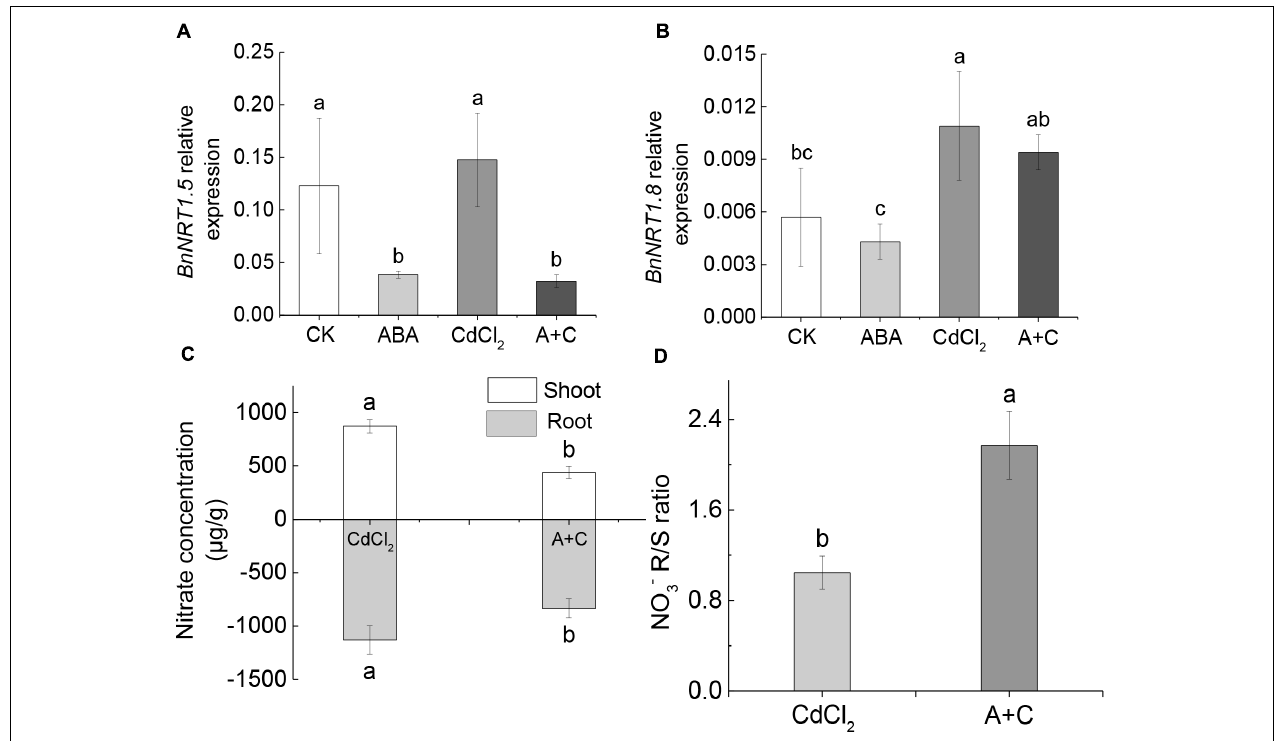
FIGURE 6 | Exogenous ABA affects the distribution of NO − 3 under Cd conditions. (A) Gene expression of BnNRT1.5 in different treatments (CK, ABA, CdCl 2 , A+C). (B) Gene expression of BnNRT1.8 . (C) The concentration of NO − 3 in the shoot and root. (D) [NO − 3 ] ration between root and shoot. Data represent means ± SE ( n = 4). Bars with the same letter indicate no significant difference at P < 0.05 level by the method of LSD.